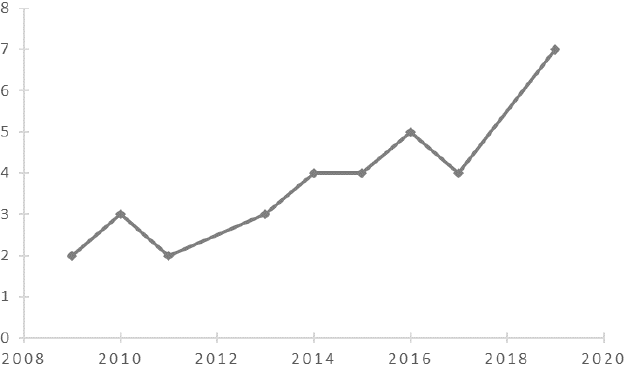
Figure 2. Number of published journal articles meeting inclusion criteria (2008–2020). Note: Year 2020 was included in this figure and in all analyses, even though not all papers from this year are likely to have been published at the time of the review.